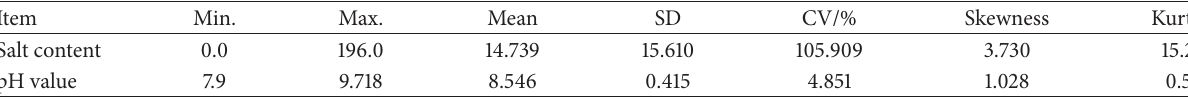
Table 1: Statistical results of salt content (g/kg) and pH value.